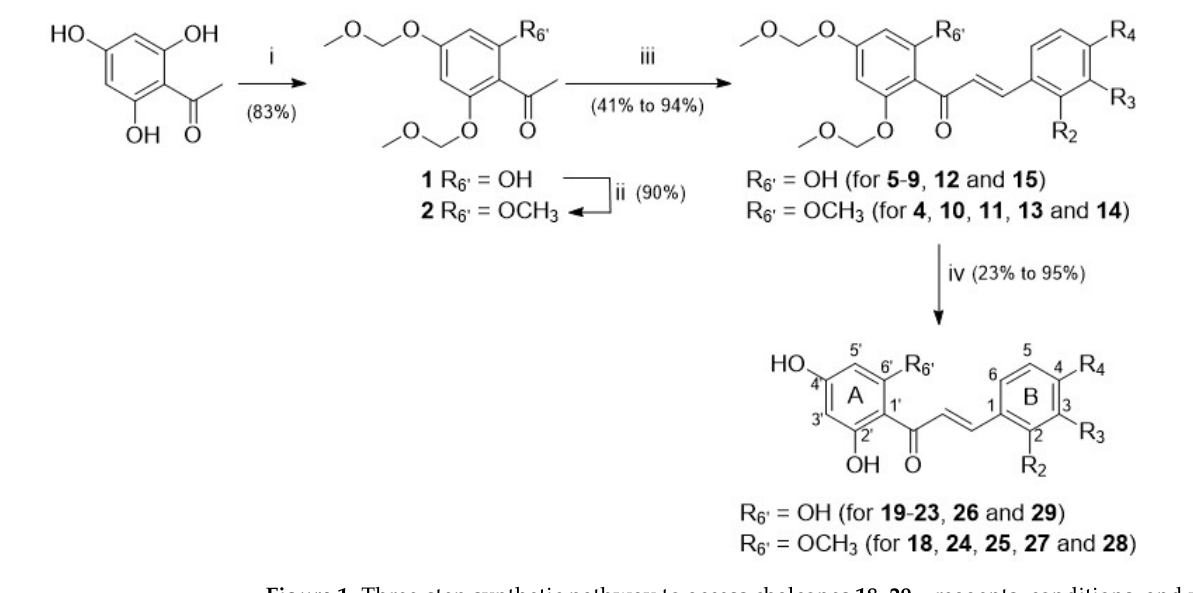
Figure 1. Three-step synthetic pathway to access chalcones 18–29 —reagents, conditions, and yields (in %): ( i ) MOMBr, N , N -diisopropylethylamine, THF, RT, 2 h; ( ii ) MeI, NaH, DMF, RT, 1 h; ( iii ) method A: KOH, EtOH, RT, 48 h; method B: NaOH, dioxane:water (1:1), RT, 24 h; ( iv ) method C: HCl, MeOH,